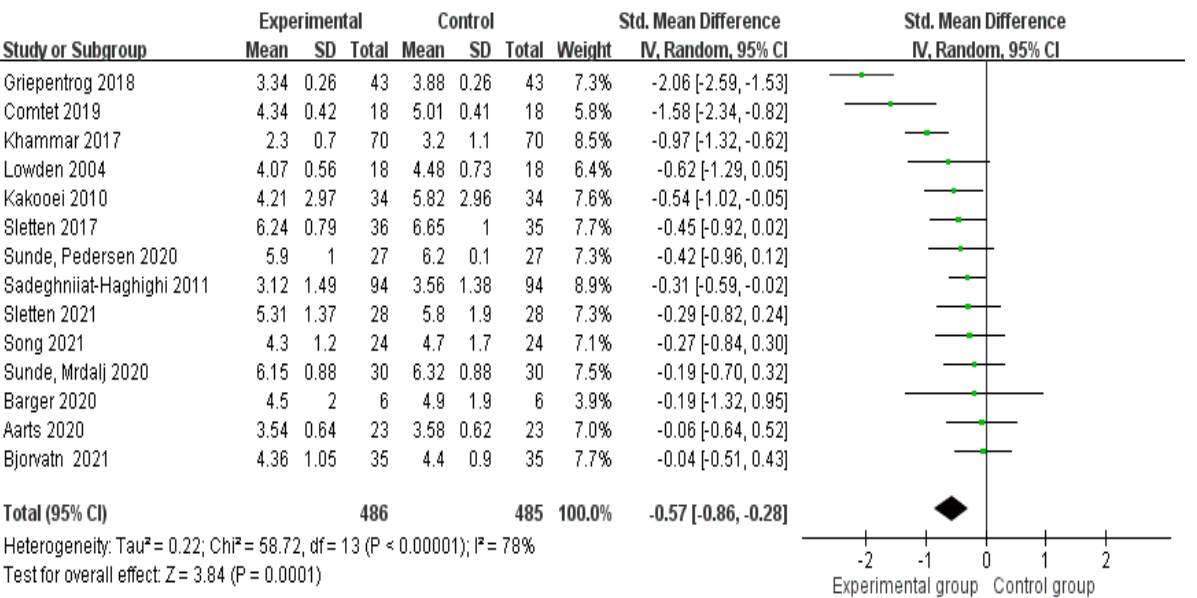
Figure 4. Forest plot of the effect of lighting interventions in improving sleepiness of night − shift workers.